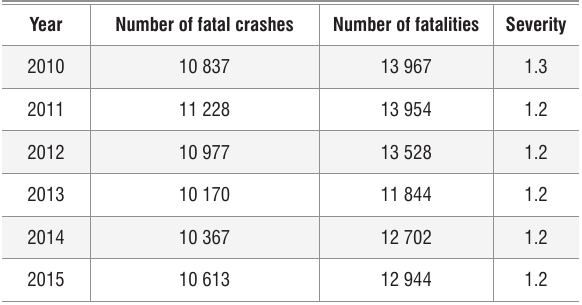
Accident information for all fatal road accidents reported in 2010 to 2015 Number of fatal crashes